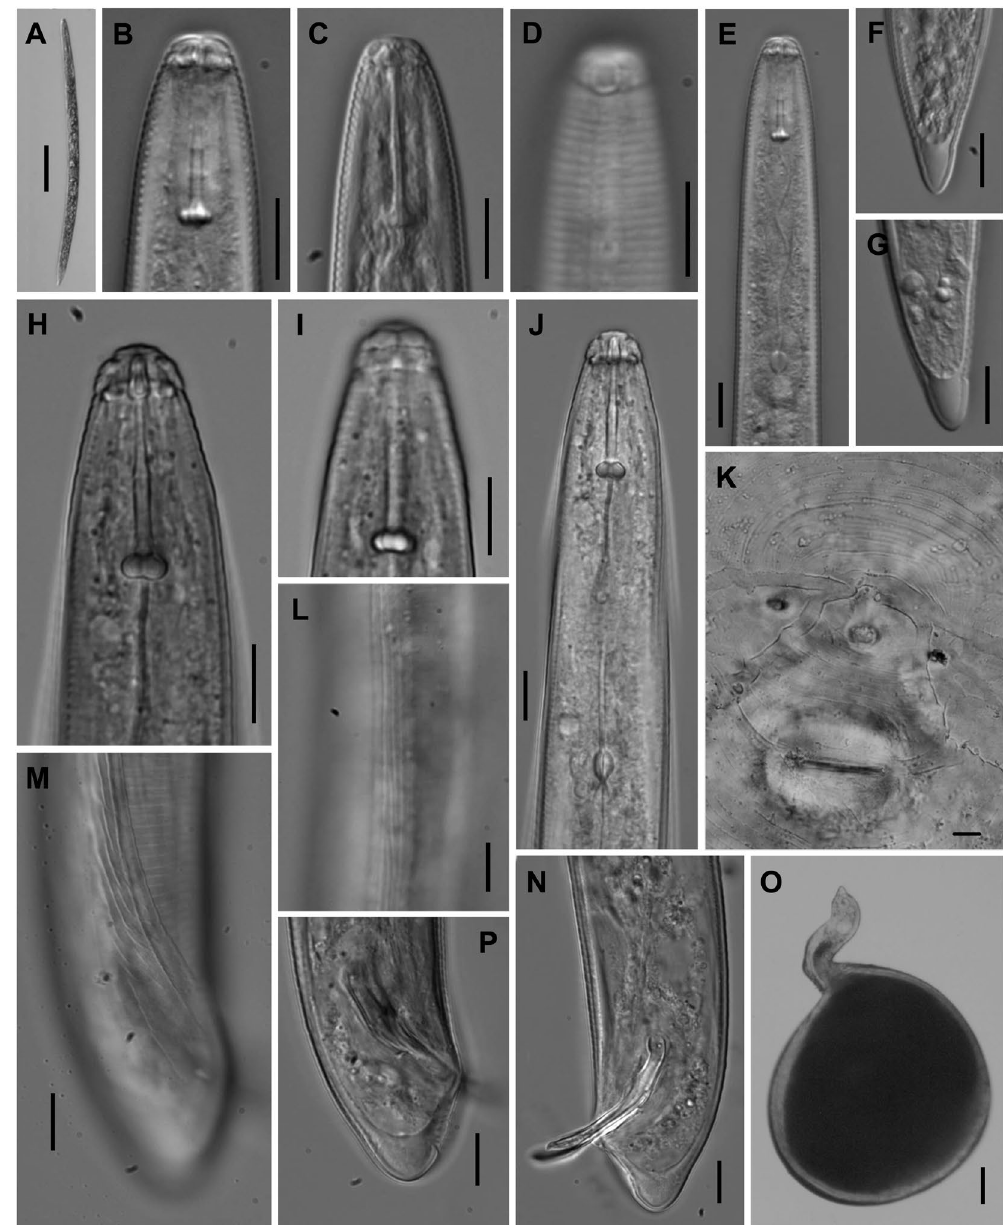
Figure 2. General morphology of Meloidogyne nataliei (LM). ( A–G ) Second-stage juveniles; ( H–J,L–N,P ): Male; ( K,O ): Female. ( A,O ) Entire body. ( B,C,H ) Anterior region in median lateral view. ( D,I ) Anterior region in surface lateral view. ( E,J ) Pharyngeal region. ( K ) Perineal pattern. ( L ) Mid-body lateral field. ( F,G,M,N,P ) Caudal region. (Scale bars: A,O: 100 µ m; B–J, K–N, P = 10 µ